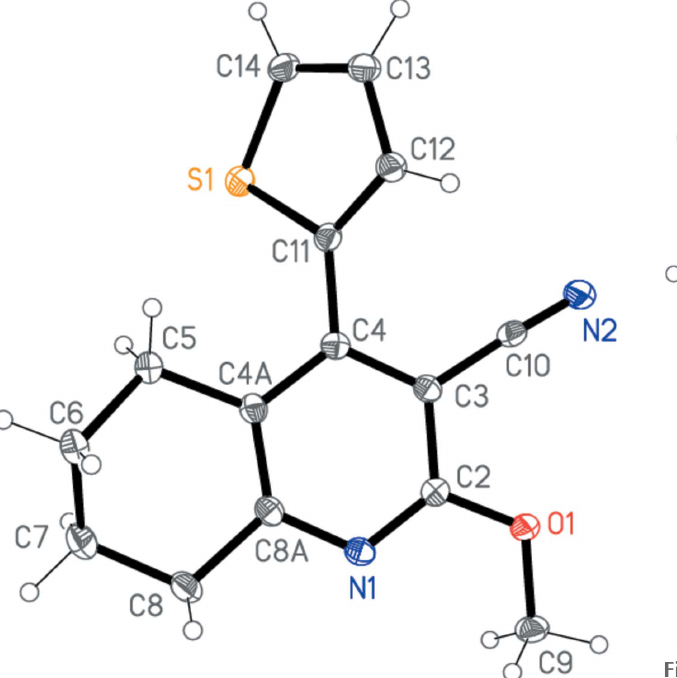
Figure 1 The molecule of 1a in the crystal. Ellipsoids represent 50% probability